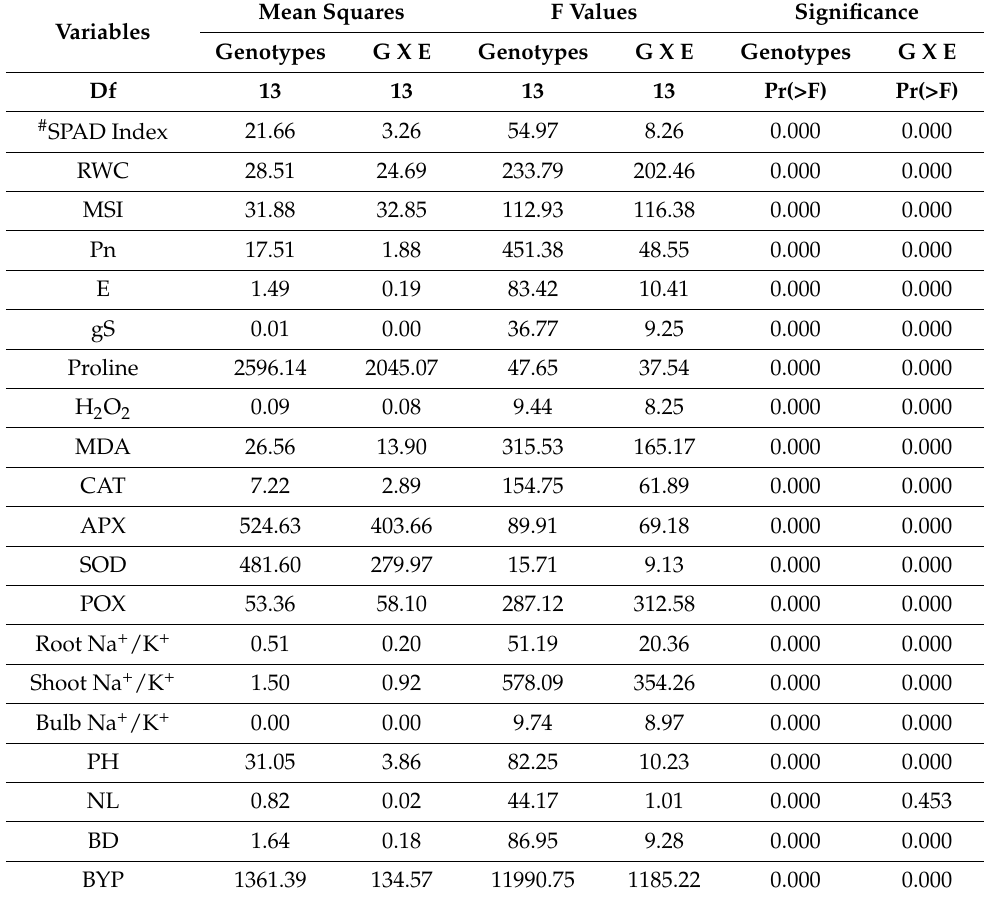
Table 3. Variance analysis of morpho-physiological and biochemical traits of 14 selected onion accessions over control and saline